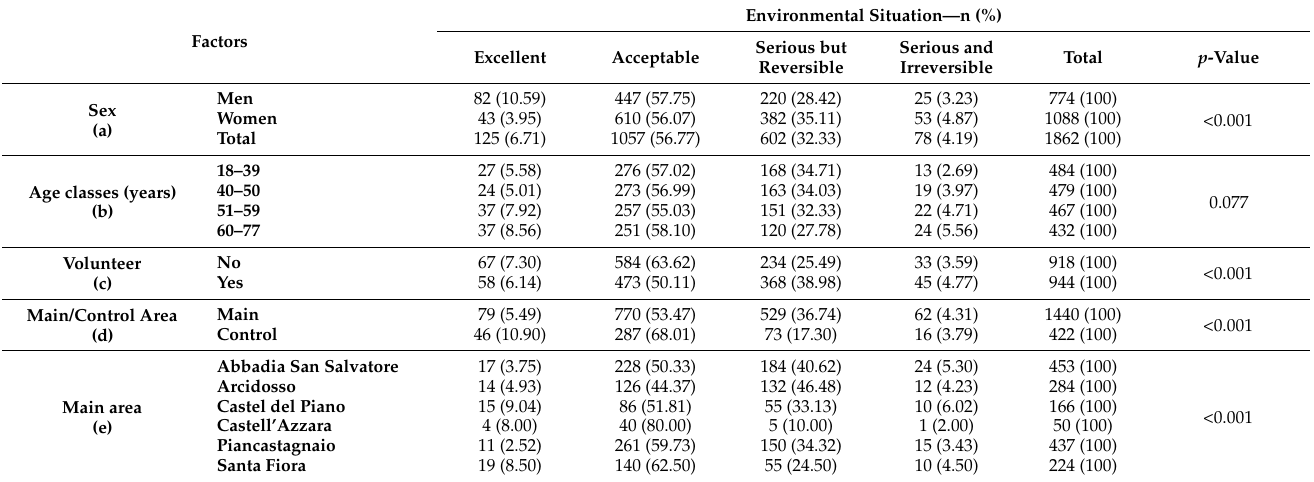
Table 8. Answers to question 12.5 “How do you judge the environmental situation of the municipality where you live in?” according to sex, age group, being a voluntary participant or not, belonging to main/control area and residing in one of the most exposed municipalities of the main